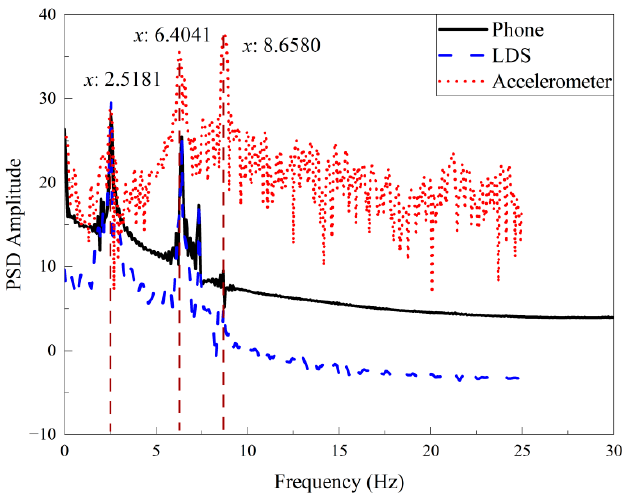
Figure 23. PSD comparison of different equipment.